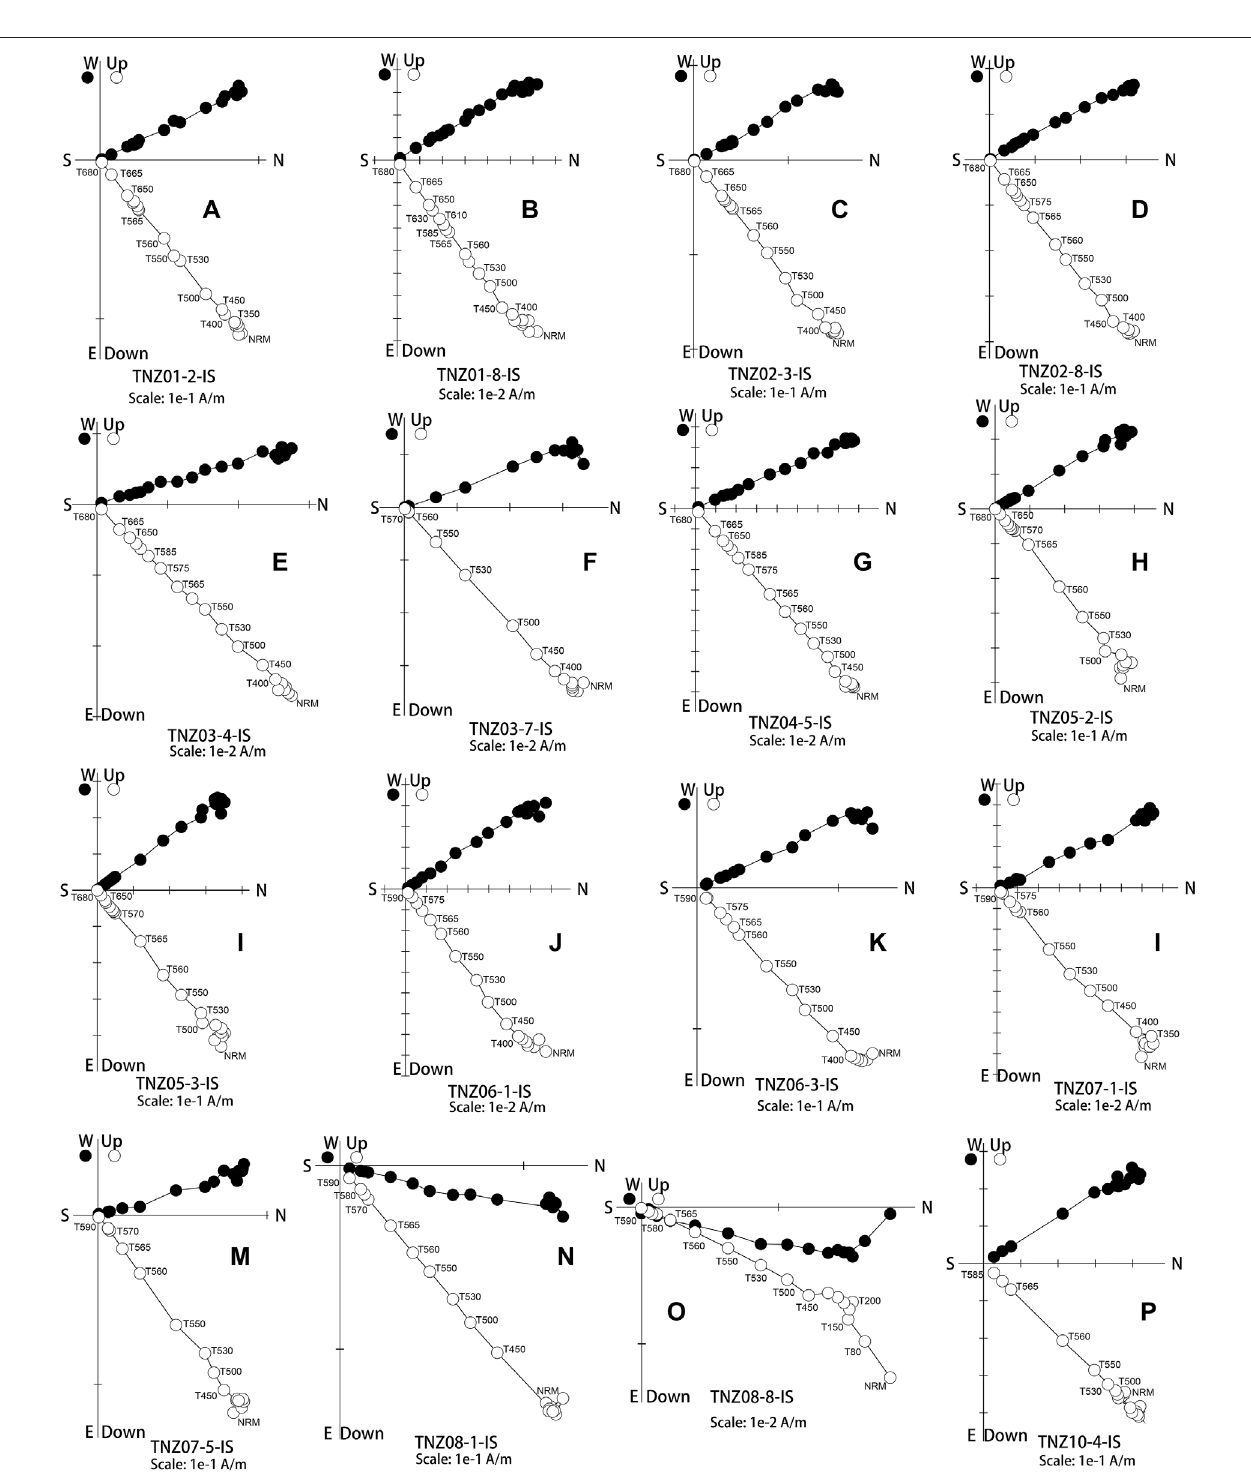
FIGURE 7 | Orthogonal vector projection of thermal demagnetization results for representative specimens of the Lower Cretaceous Zonggei Formation volcanic rocks, which are plotted in geographic coordinates. Closed (open) circles represent projection of vector end-points onto the horizontal (vertical) plane. Thermal ( ° C) demagnetization steps are labeled with the capital letter T and are followed by the temperature step ( e.g., T500).